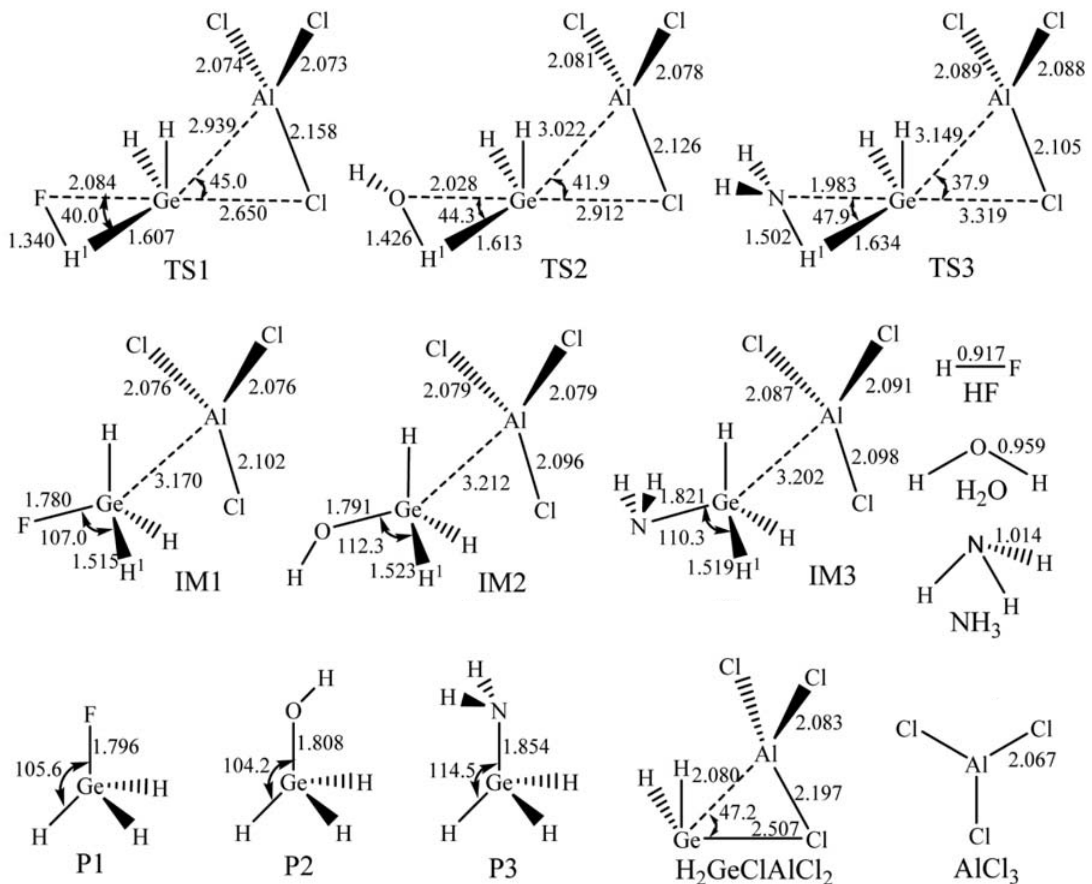
Figure 2. The geometries of the stationary points [ reactants, transition states (TSs), intermediates (IMs), and products (Ps) ] of the substitution reac- tions of the germylenoid H GeClAlCl with HF, H O, and NH in gas phase calculated at MP2/6-311+G ( d , p ) level (Bond lengths are given in Å 2 2 2 3 and angles in